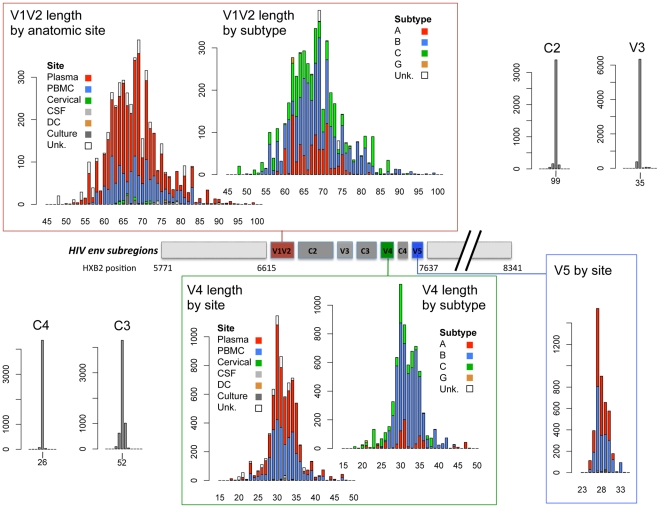
Schematic diagram of HIV-1 env subregions (center bar) and distribution of subregion loop lengths (surrounding bar graphs).The center bar depicts the linear arrangement of subregions V1V2 through V5 within the HIV Env gp120 protein. The amino acid length distribution of each subregion is shown in the linked bar graphs, including sequences in the cross-sectional dataset, the longitudinal dataset and the transmission data described in Text S1. Length distributions in V1V2 and V4 data are shown by isolation site (PBMC  =  blue bars, plasma  =  red bars, cervical cells  =  green bars, CSF  =  light gray bars, dendritic cells  =  orange bars, cell culture  =  dark gray bars, and cells from unknown anatomic compartments represented by open bars), and by subtype (subtype B  =  blue bars, subtype A  =  red bars, subtype C  =  green bars, subtype G  =  orange bars, untyped sequences  =  open bars). V5 sequences were all of subtype B. X-axis: sequence length (amino acids); Y-axis: number of sequences.